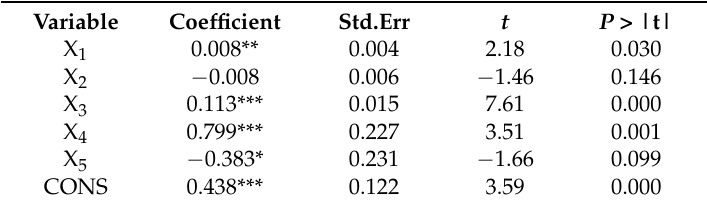
Table 6. Tobit regression analysis of factors affecting water use efficiency. Variable Coefficient